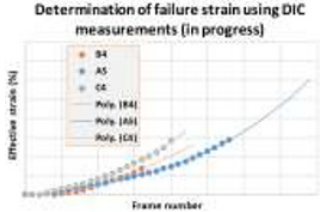
Fig. 5. Example of 2D-DIC analysis Fig. 6. Example of dynamic tracking